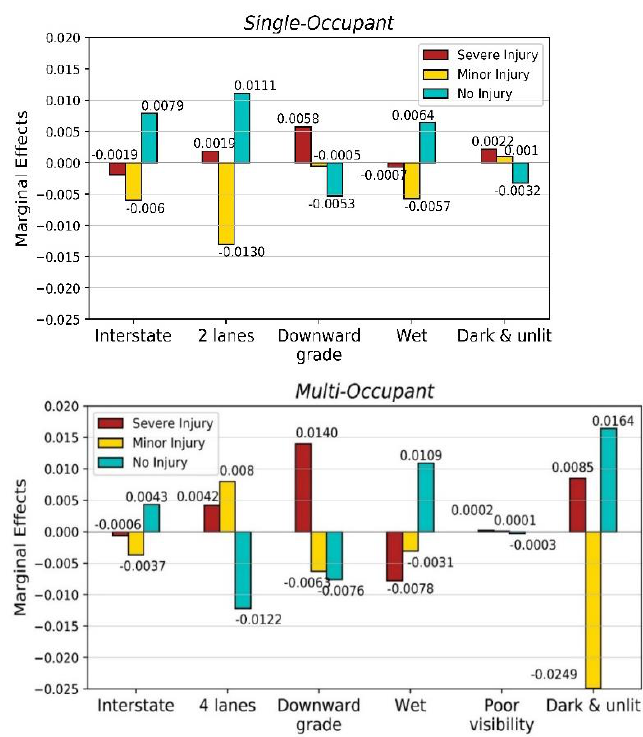
Figure 3. Estimated marginal effects of Roadway/Environmental Characteristics.